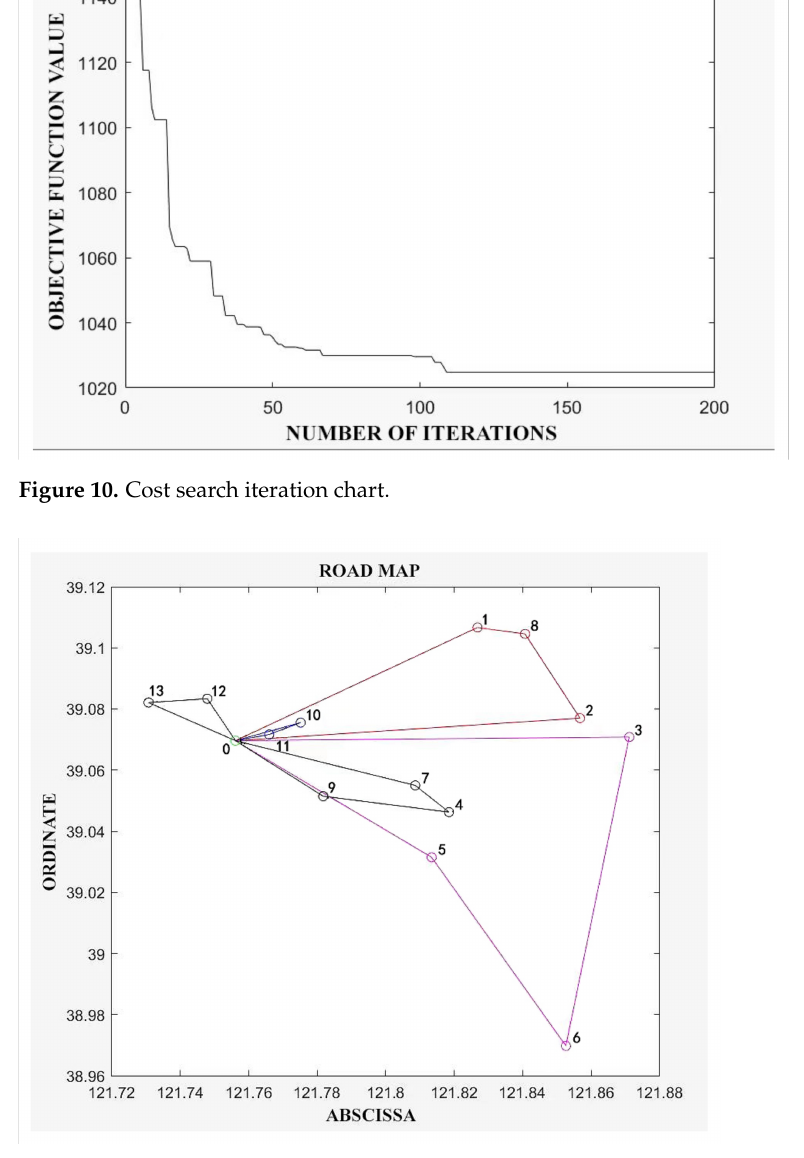
Figure 11. Optimized path planning